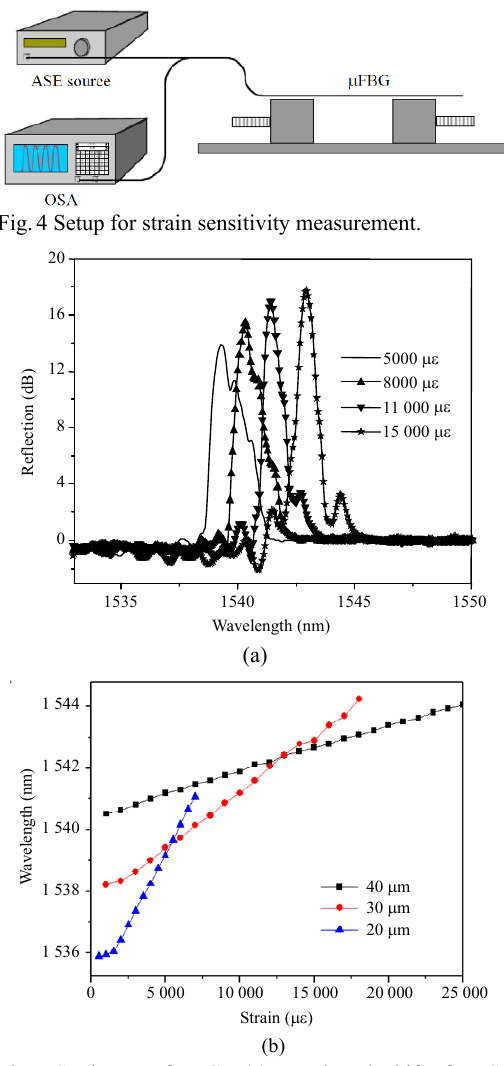
Fig. 5 Strain test of FBGs: (a) wavelength shift of FBG with fiber diameter of 30  m under strain test and (b) a comparison of tensile strain responses of FBGs in different diameter